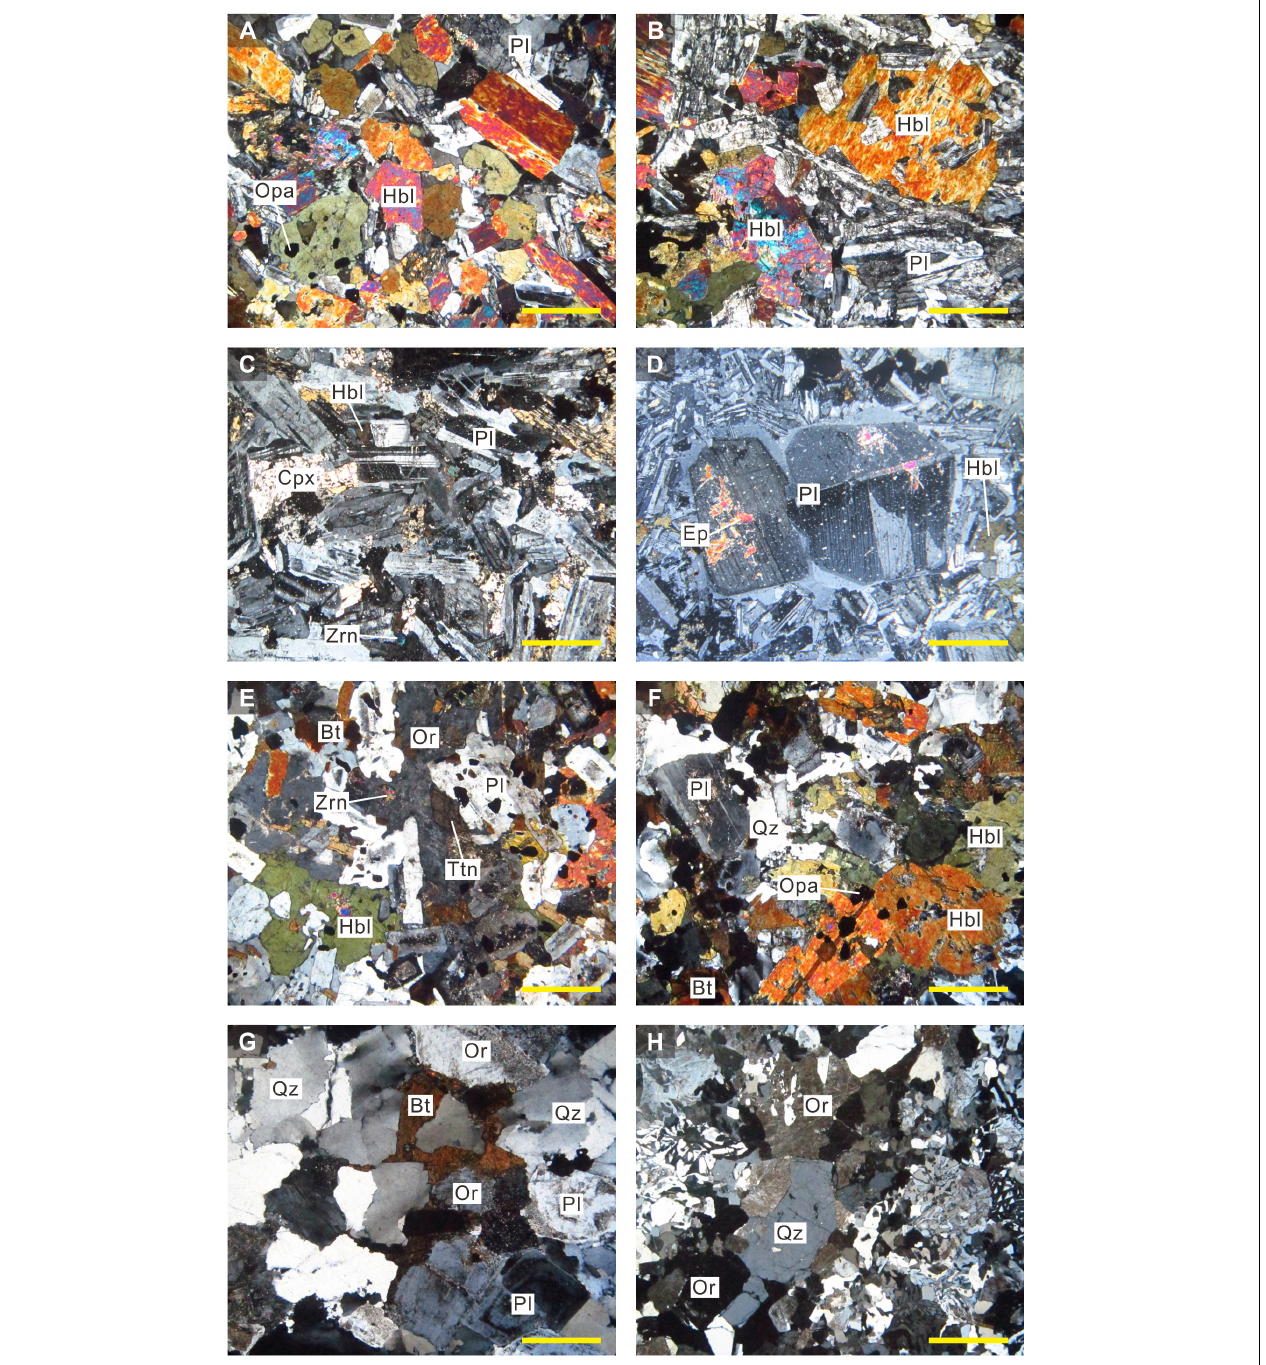
FIGURE 3 | Photomicrographs of rocks from the Takht batholith. (A) Granular texture shown by diorite consisting of interlocking grains of hornblende and plagioclase. (B) Poikilitic hornblende enclosing plagioclase in a diorite. (C) Cumulate texture shown by diorite consisting of a framework of cumulus plagioclase with intercumulus clinopyroxene and hornblende. (D) Coarse plagioclase crystals showing resorbed boundaries in a fine-grained matrix of plagioclase and hornblende in a diorite sample. (E) Granular texture shown by granodiorite consisting of interlocking grains of hornblende, biotite, plagioclase, and orthoclase. (F) Granular texture shown by monzogranite consisting of interlocking grains of hornblende, biotite, plagioclase and quartz. (G) Granular texture shown by monzogranite consisting of interlocking grains of biotite, plagioclase, orthoclase, and quartz. (H) Graphic texture, which is made up of intergrown orthoclase and quartz, shown by syenogranite. Perthite texture is observed in some orthoclase grains (upper center). All photomicrographs were taken under cross-polarized light and the yellow bars in the lower right of each frame denote length of 1 mm. Mineral abbreviations are used after Whitney and Evans (2010), except for minerals that have no recommended abbreviations: Bt = biotite, Cpx = clinopyroxene, Ep = epidote, Hbl = hornblende, Opa = Fe-Ti oxides, Or = orthoclase, Pl = plagioclase, Qz = quartz, Ttn = titanite, Zrn = zircon.